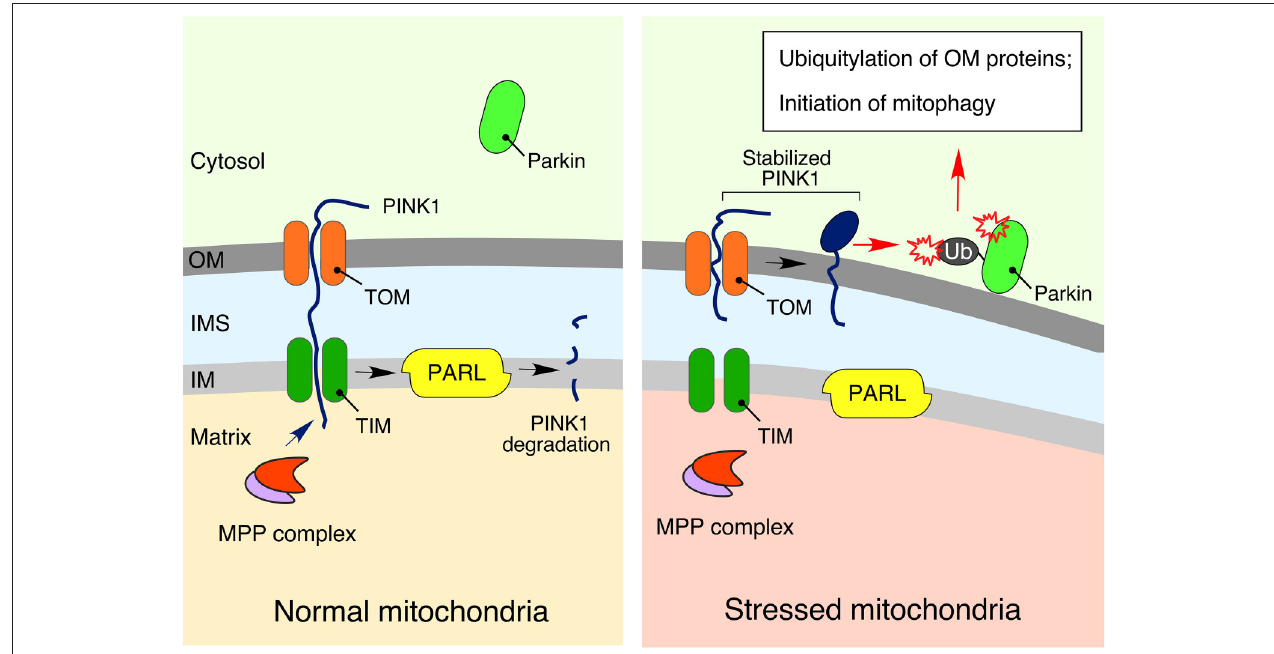
FIGURE 4 | The PINK1-Parkin signaling relay. Under physiological conditions, phosphatase and tensin homolog (PTEN)-induced ubiquitin kinase 1 (PINK1), a key regulator of mitophagy and mitochondrial turnover, is imported into the mitochondria via the translocases of outer (TOM) and inner (TIM) membranes. It is subsequently degraded by presenilin associated rhomboid-like protease (PARL) in the IM ( Jin et al., 2010). However, in response to mitochondrial damage, stabilized PINK1 accumulates on the outer membrane (OM), promoting recruitment, and activation of the E3 ubiquitin ligase parkin, followed by ubiquitylation of OM-associated proteins, and initiation of mitophagy (Kondapalli et al., 2012; Kane et al., 2014; Kazlauskaite et al., 2014; Koyano et al., 2014; Ordureau et al., 2014). More details are available in the